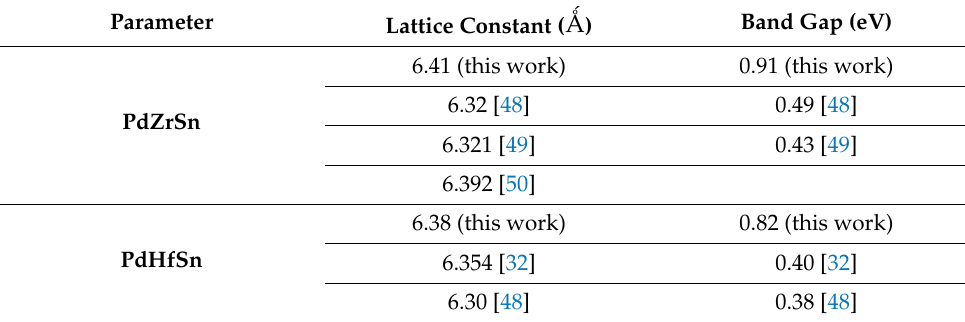
Figure 1. The crystal structure of PdXSn (X = Zr, Hf) compound. Blue, green, and red color represent Pd, X, and Sn atoms, respectively. The position occupied by Pd, X, and Sn are (0.25, 0.25, 0.25); (0.5, 0.5, 0.5); and (0, 0, 0), respectively. Table 2. Optimized lattice parameters of PdXSn (X = Zr, Hf) compound. Parameter Lattice Constant ( Ǻ